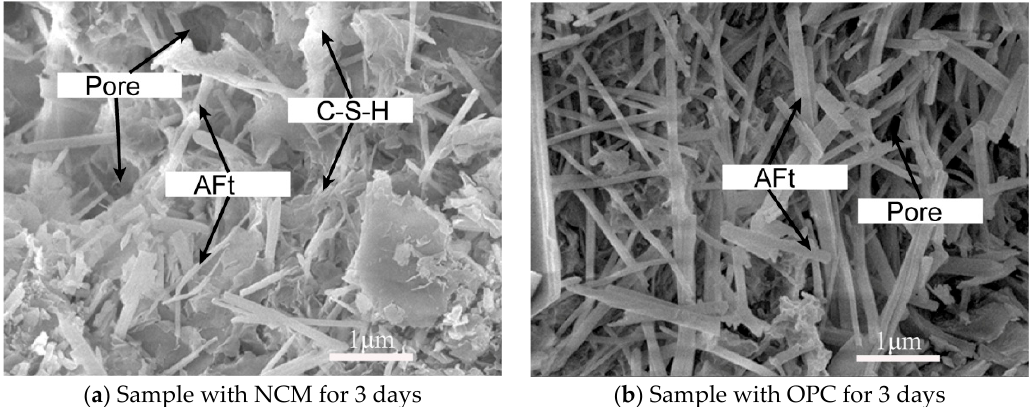
Figure 10. SEM images of samples with NCM and OPC for 3 days of curing time.